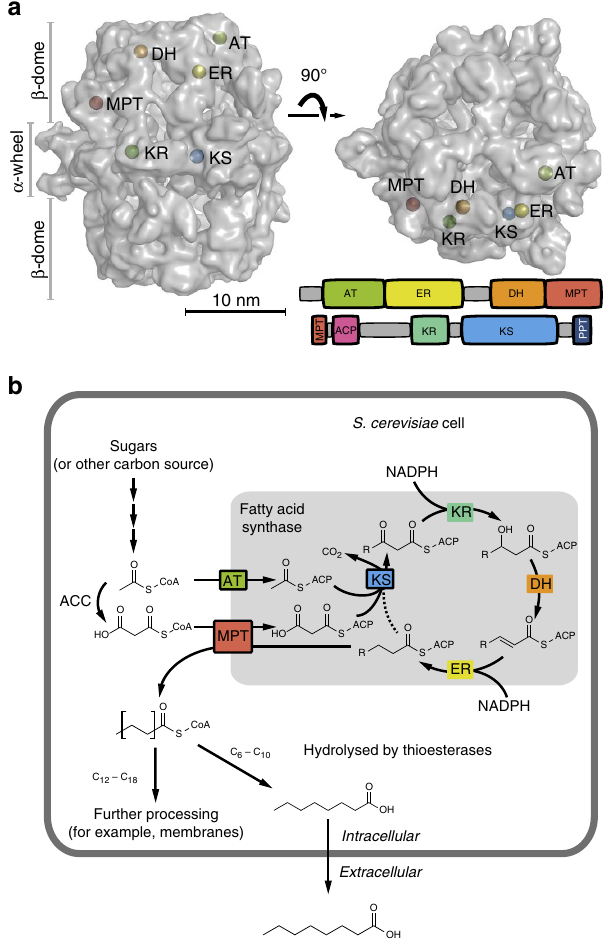
Figure 1 | Fatty acid synthesis in S. cerevisiae . ( a ) Two polypeptides, the 207kDa a -chain and the 229kDa b -chain, assemble to a barrel-shaped a 6 b 6 -heterododecameric complex that encloses two reaction chambers, each formed by a b -dome and the a -wheel. The b -chain harbours the domains acetyl transferase (AT), enoyl reductase (ER), dehydratase (DH) and malonyl/palmitoyl transferase (MPT), and the a -chain the domains acyl carrier protein (ACP), ketoacyl reductase (KR), ketoacyl synthase (KS) and the phosphopantetheine transferase (PPT). The barrel- shaped structure of S. cerevisiae FAS is shown with one set of active centres indicated (based on protein data bank (PDB) code 3HMJ (ref.